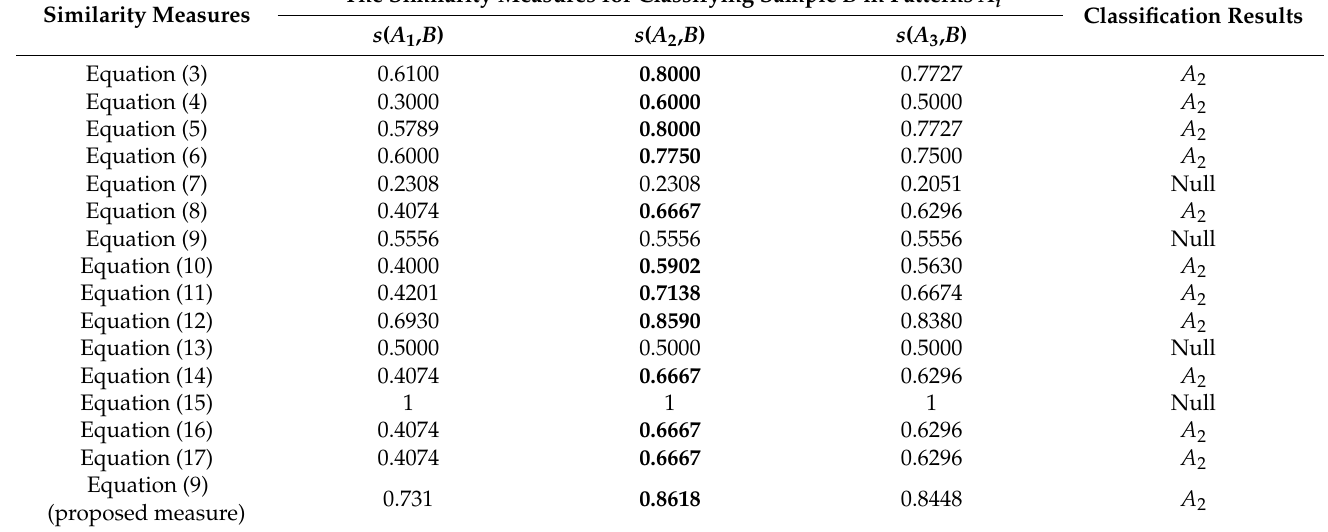
Table 3. Classification results for Example 2.